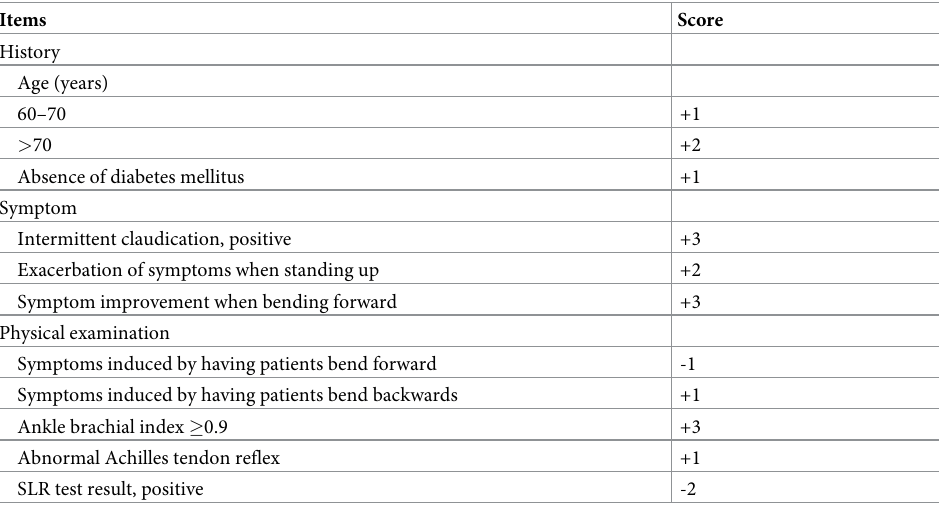
Table 1. A clinical DST for identifying patients with LSS